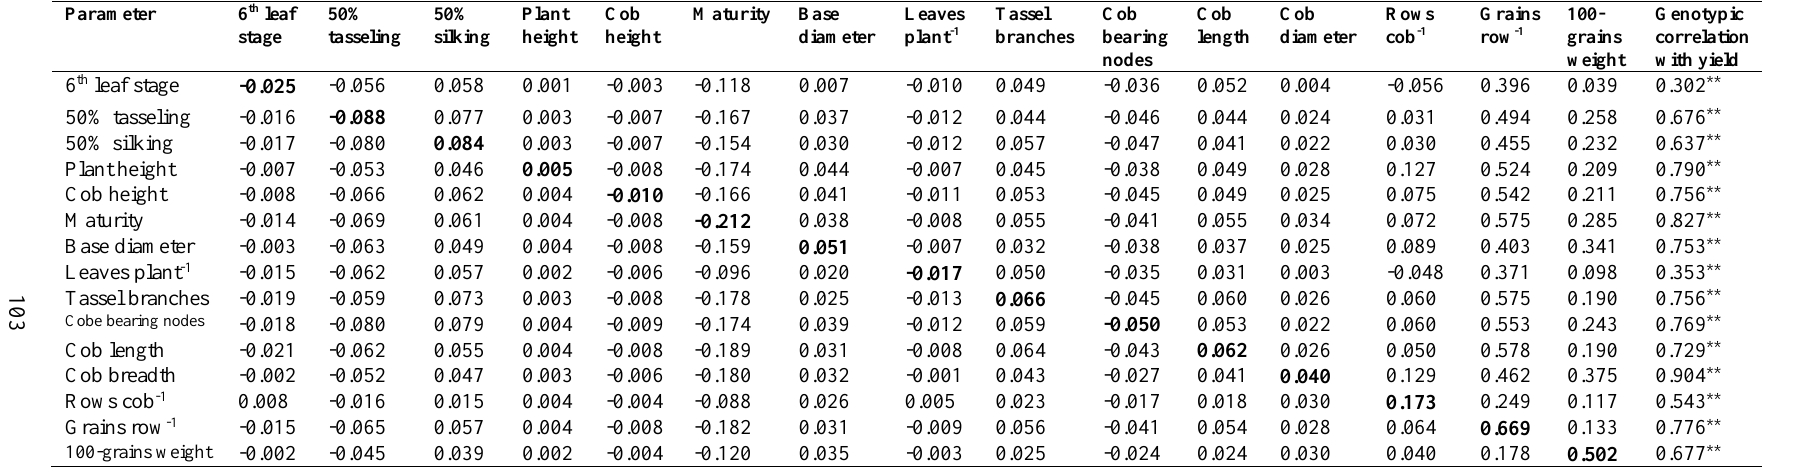
Table 4. Partitioning of the genotypic correlation coefficient into direct (bold) and indirect effects.